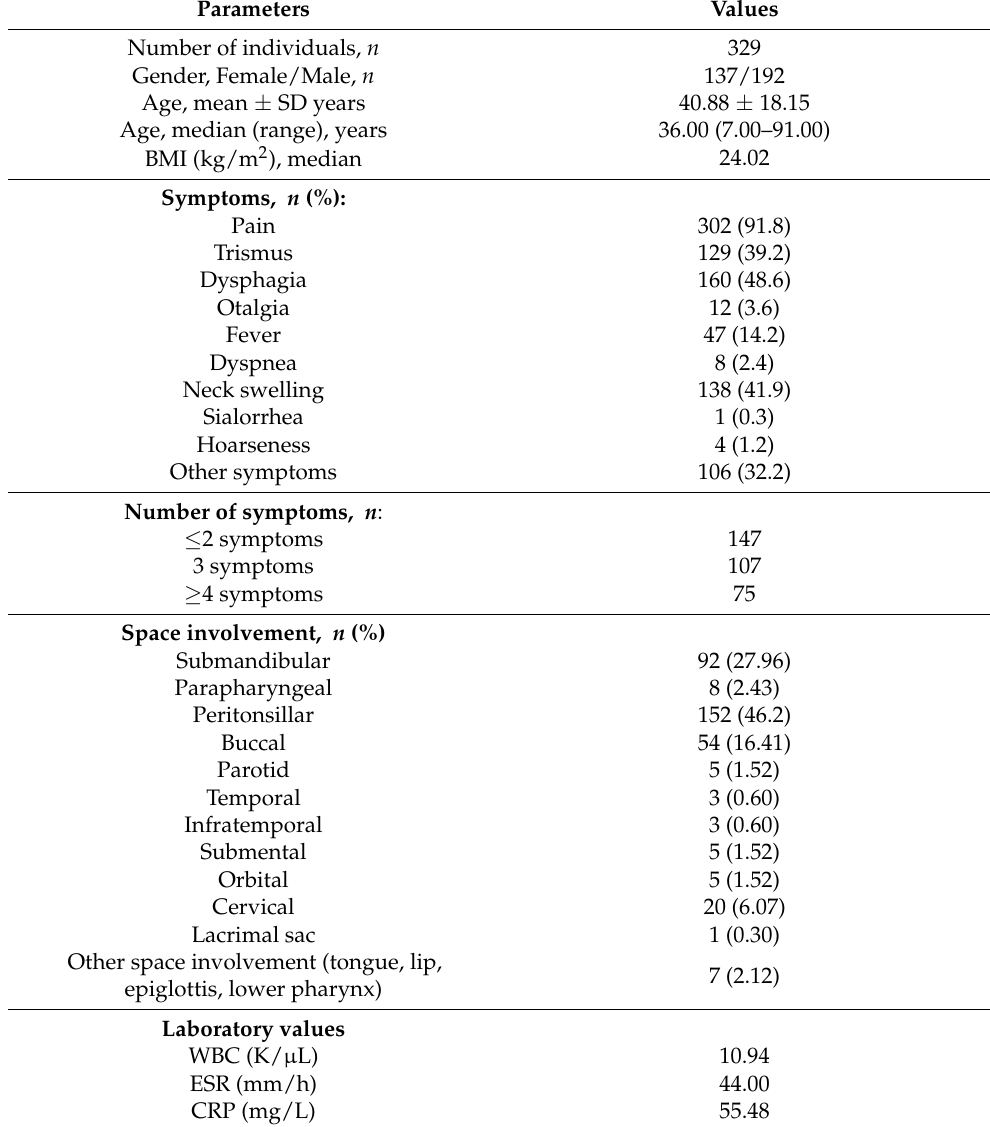
Table 1. Demographic, clinical, and laboratory characteristics of oral and maxillofacial infection patients. Parameters Values Number of individuals, n